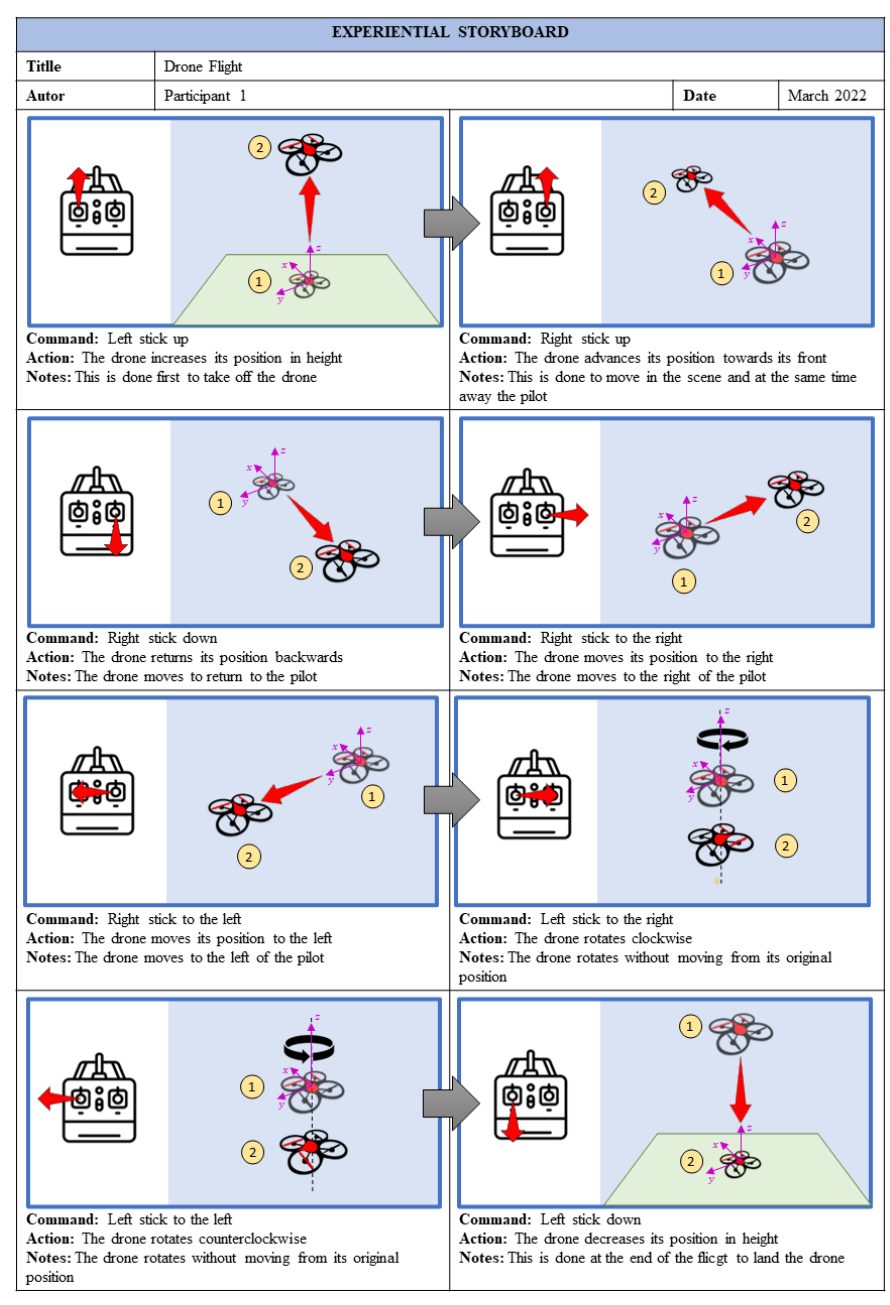
Figure 12. Storyboard containing the commands and actions of the drone